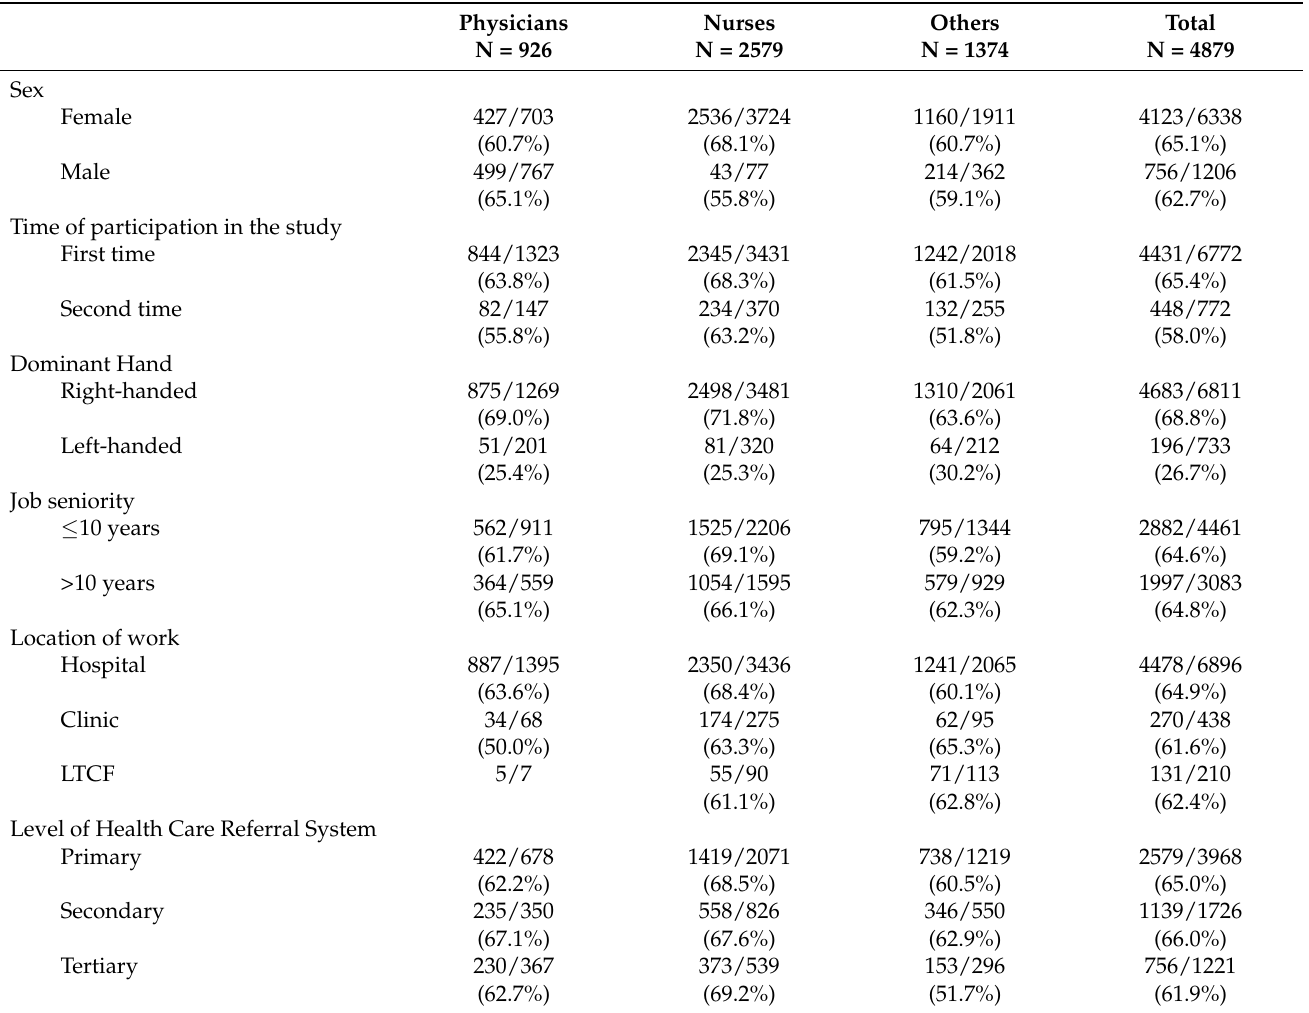
Table 3. Characteristics of participants properly disinfecting their